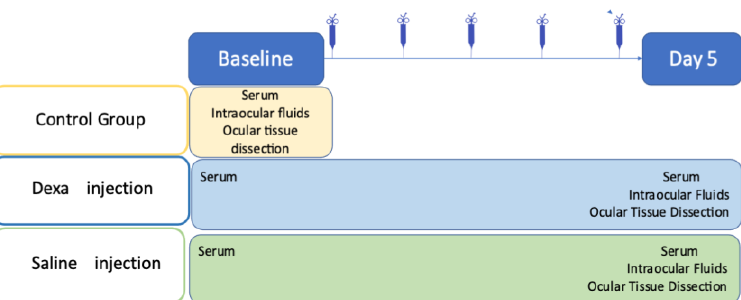
Figure 7. Schematic representation of the experiments. Serum was extracted from blood samples, intraocular fluids include aqueous humour and vitreous from each eye. Ocular tissue dissection separated the iris-ciliary body complex, the neural retina, the retinal pigment epithelium (RPE)- choroid complex or each eye separately.